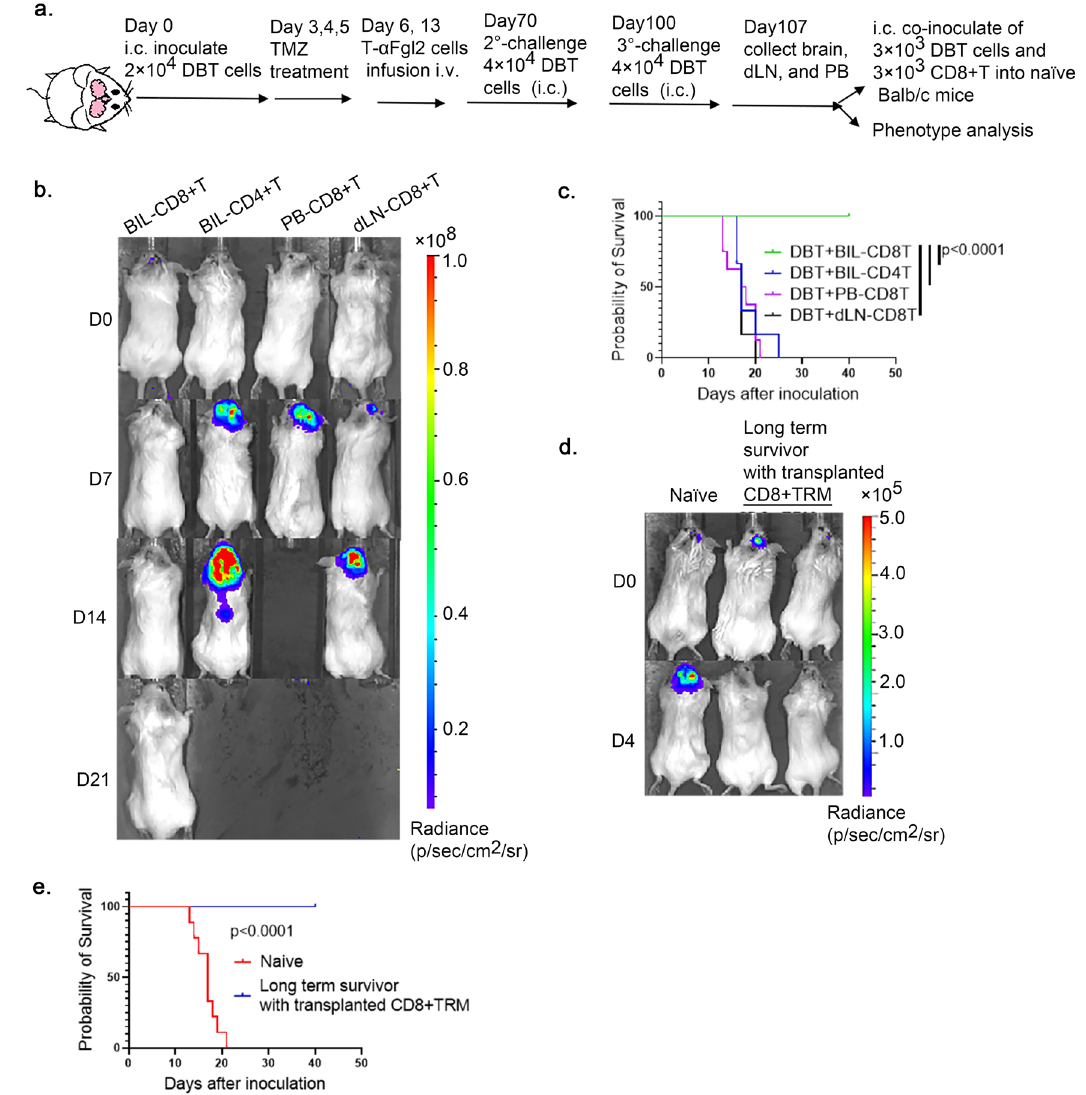
Fig.4|T RM -likecellscanbeadoptivelytransferred.a Schematicofexperimental design. On days 70 and 100 after the fi rst tumor cell inoculation, T- α FGL2-treated survivorswererechallengedwithDBTtumorcellsintracranially(i.c.).Onday7after the thirdchallenge(day100)withtumorcells, the mice wereeuthanized,and their brains, draining lymph nodes (dLN), and peripheral blood (PB) were collected. b Representative bioluminescence images of naïve Balb/c mice coinoculated i.c. with 3×10 3 DBT glioma cells and 3×10 3 T cells. Images show gliomas in mice coinoculated with CD8 + T cells in the brain (BIL-CD8 + T), CD4 + T cells in the brain (BIL-CD4 + T),CD8 + Tcellsinperipheralblood(PB-CD8 + T),orCD8 + Tcellsindraining lymph nodes (dLN-CD8 + T). CD8 + T cells and CD4 + T cells were sorted by fl ow